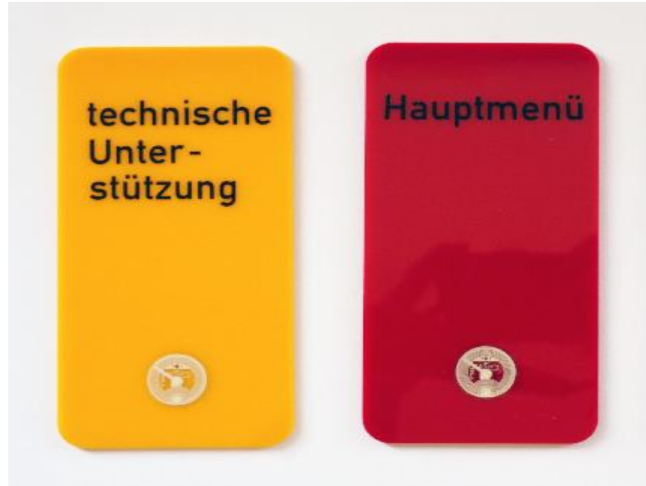
Figure 1. Two exemplary SmartCards with NFC chip on the bottom.